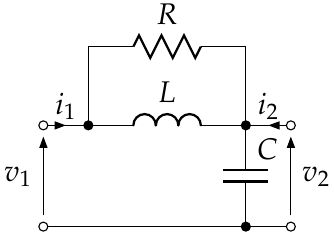
Figure 4. Standard line/load filter with purely resistive